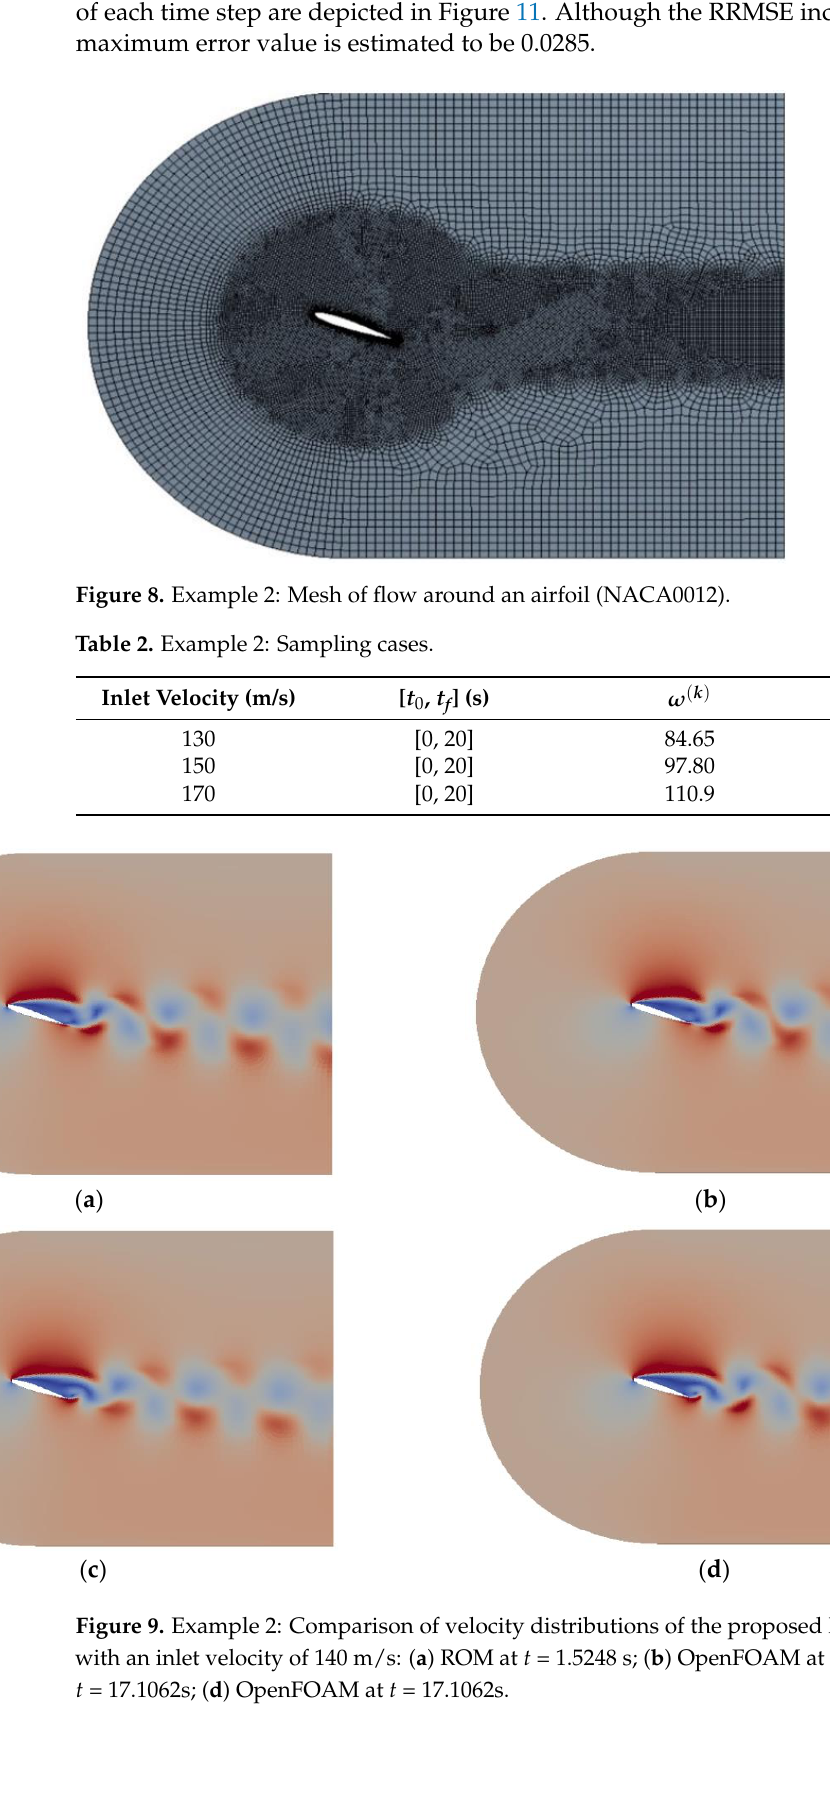
( d ) Figure 10. Example 2: Comparison of x-directional velocity profiles of the proposed ROM and Open- FOAM at several locations: ( a ) 0 – 0.5 s at (4.1175, 2.9034); ( b ) 18 – 18.5 s at (4.1175, 2.9034); ( c ) 0 – 0.5 s at (7.1536, 1.9996); ( d ) 18 – 18.5 s at (7.1536, 1.9996).